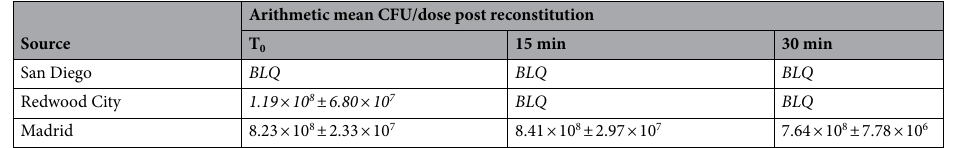
Table 2. PXVX0200 viability when reconstituted in select tap-waters from US and EU (2019). Italicized values are below the PXVX0200 lower potency limit. BLQ below level of quantification.